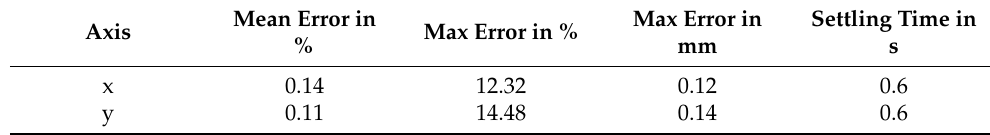
Table 3. Error metrics of experiment with current controller dynamics and both bearings